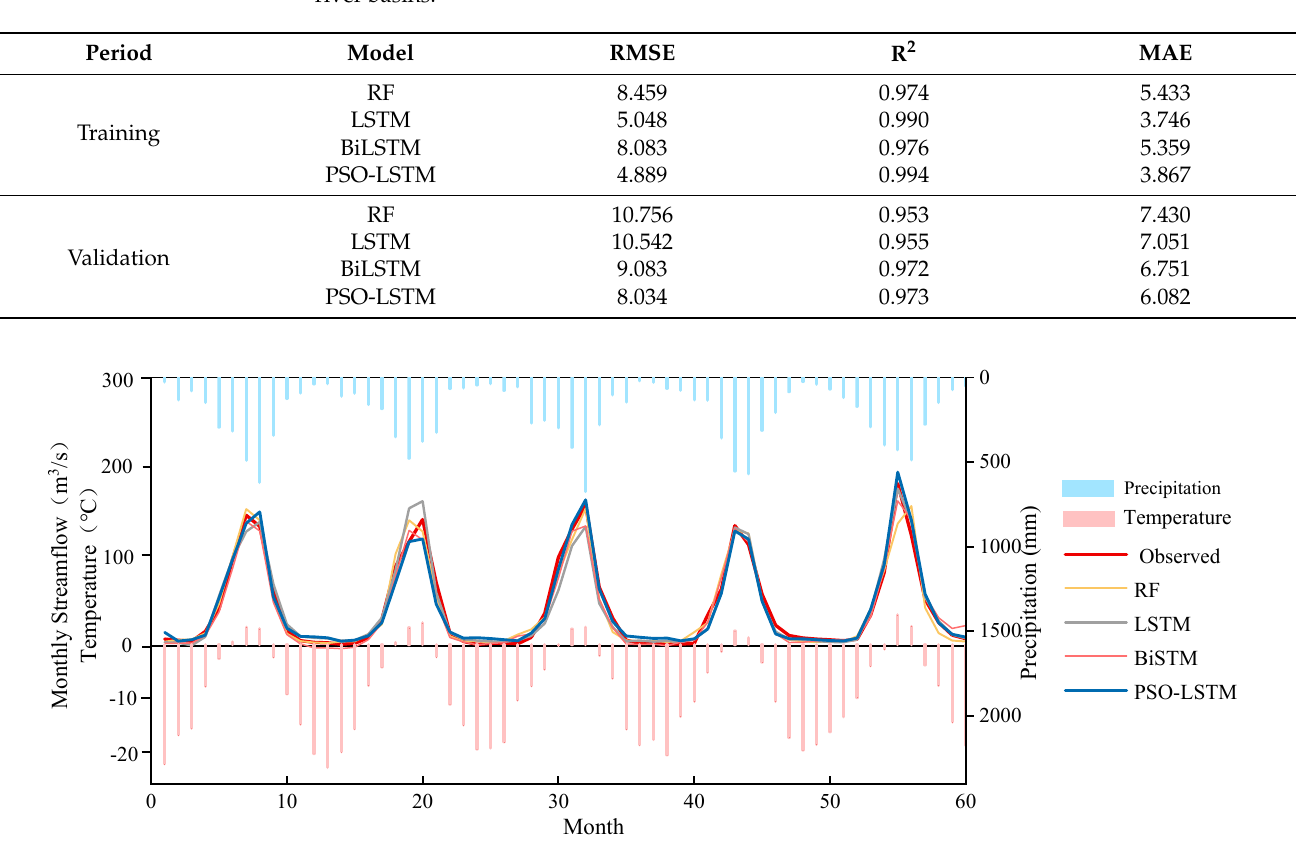
Table 3. Evaluation results of the RF, LSTM, BiLSTM and PSO-LSTM models in monthly average runoff simulation during the training period (1990–2010) and testing period (2011–2015) in the mu-zati river basins.